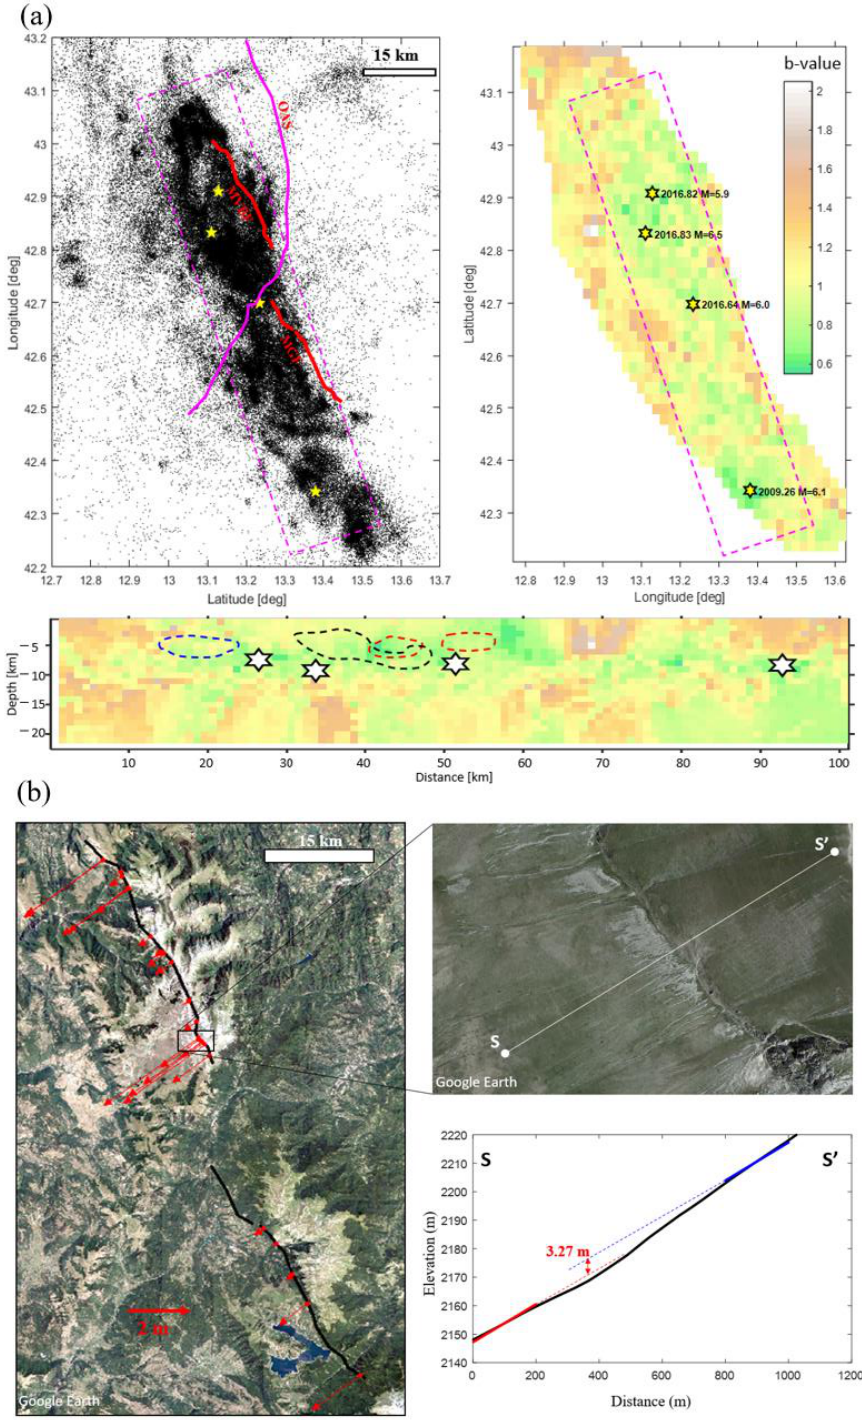
Figure 3. b -value and cumulative vertical displacements for the 2016 central Italy earthquake sequence. ( a ) Seismic activity, b -value distribution map, and cross section using the INGV earthquake catalog covering the period from 3 April 2005 to 8 October 2017. The pink dashed rectangles indicate the location of the b -value swath profile. The red, blue, and black dashed lines indicate the 60% maximum slip area of the Amatrice, the Visso, and the Norcia earthquakes. ( b ) Cumulative vertical displacements (red arrows) along the VBFS/GFS fault systems, and an example of scarp offset measurement. Red arrows represent vertical offsets of ruptures, and they are orthogonal to fault strikes.